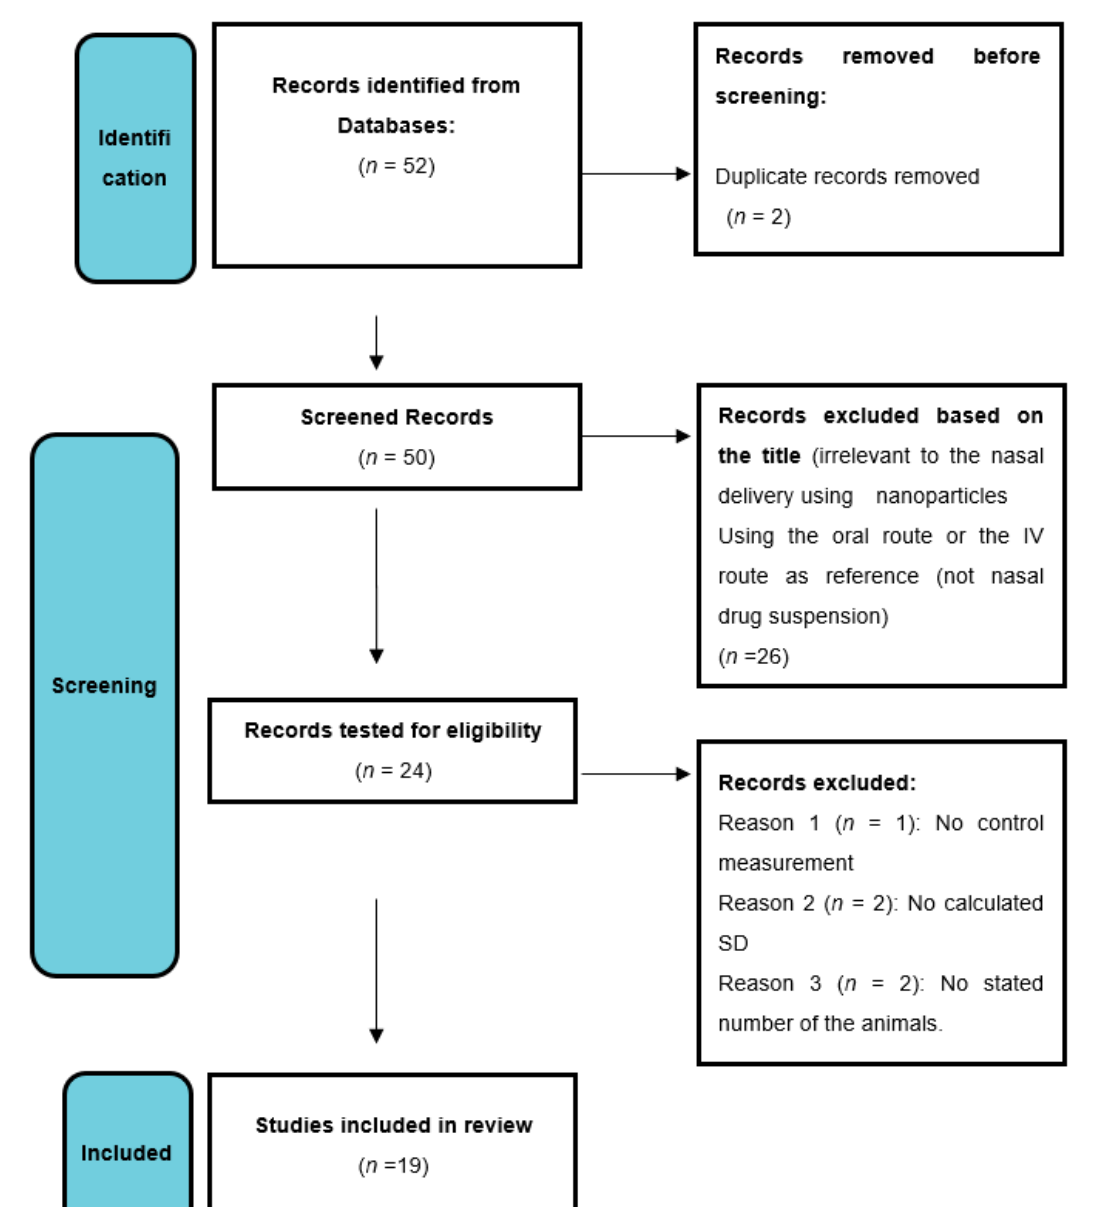
Figure 1. Conducted data-mining process as described in PRISMA guidelines.